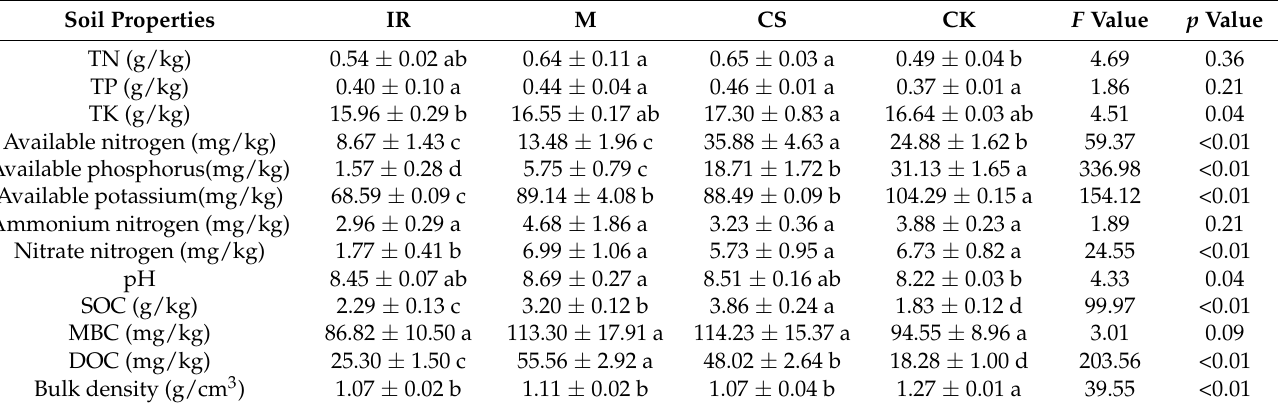
Table 1. Sample plot soil